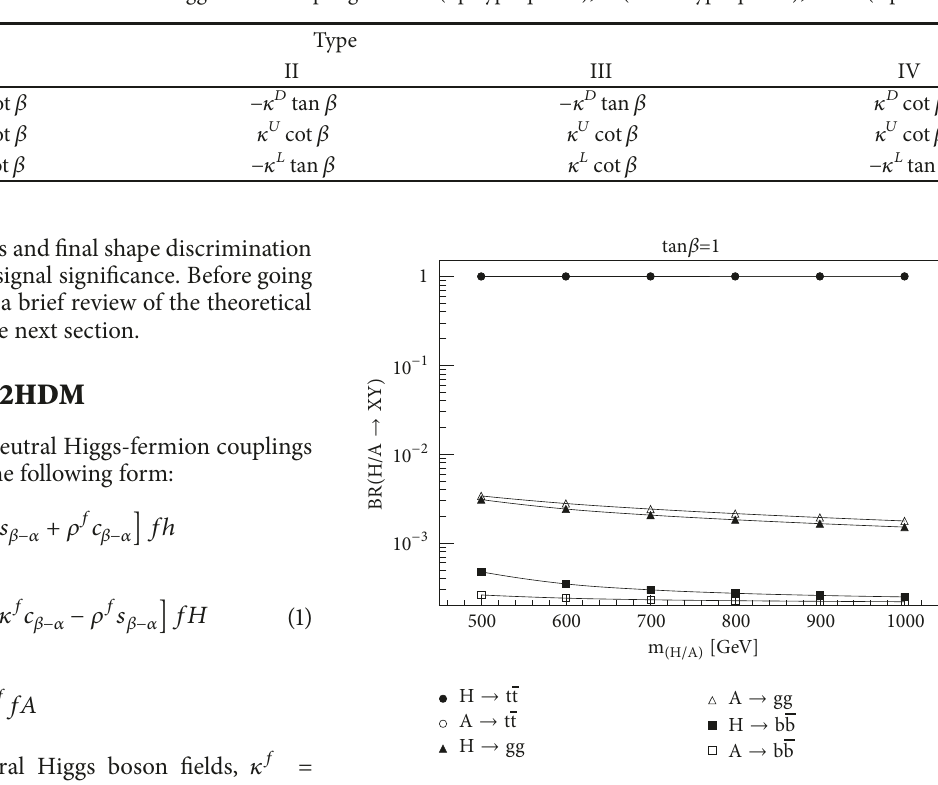
Figure 1: The branching ratio of neutral Higgs boson decays as a function of the mass. The tan 𝛽 is set to 1.